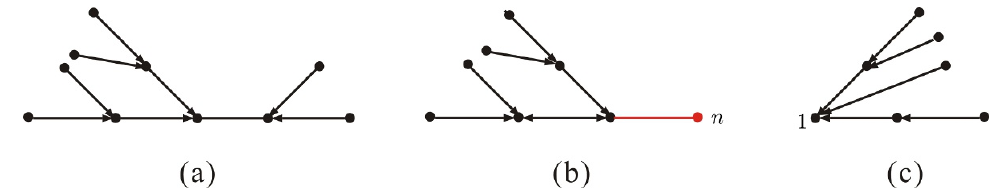
Figure 19 . Graphs (a), (b) and (c) are correspondingly typical graphs of type-I, -II,-III components in the skeleton of the T 1 part in eq. (8.12).